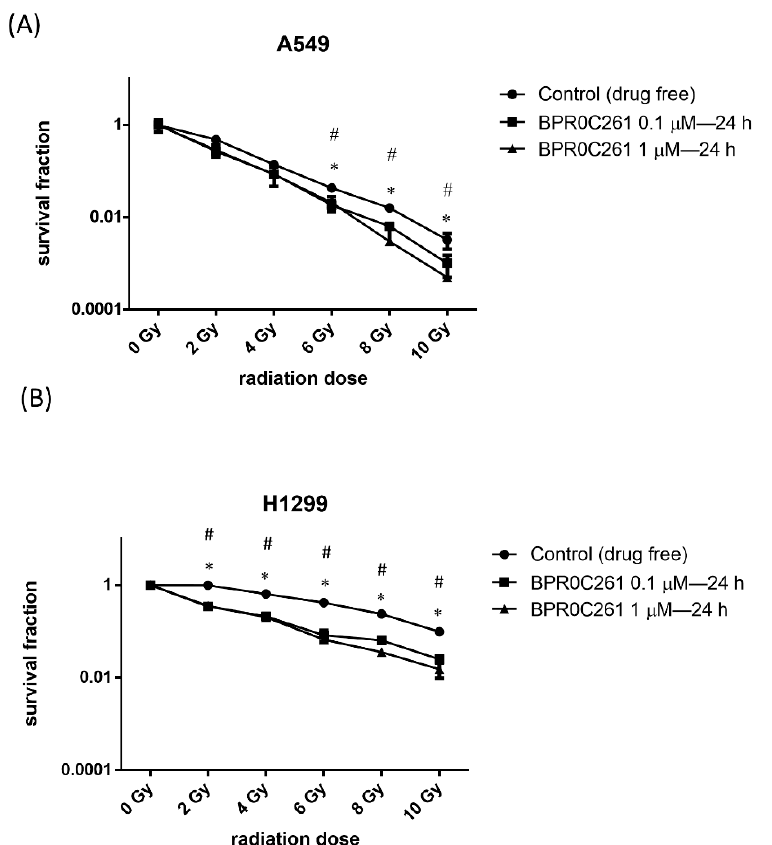
Figure 4. Effect of BPR0C261 on radiosensitivity of NSCLC cells. The survival fraction of ( A ) A549 cells and ( B ) H1299 cells exposed to different doses of X ‐ rays after treatment with BPR0C261. *: p < 0.05 for 0.1 µ M BPR0C261 treatment compared to radiation alone. #: p < 0.05 for 1 µ M BPR0C261 treatment compared to radiation alone. Table 1. Effect of BPR0C261 combining different doses of X ‐ rays on A549 cells. The SF D of BPR0C261 0.1 μ M = 0.368